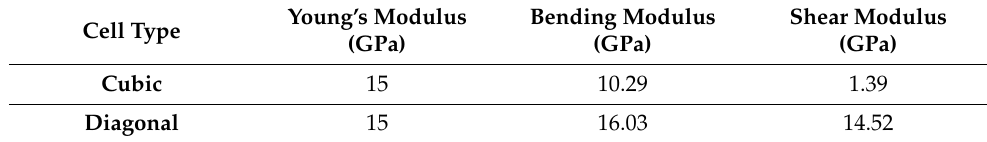
Table 3. Elastic properties from the FEA.